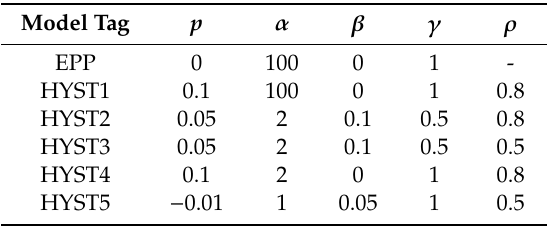
Table 2. Values of the parameters controlling the cyclic behavior of the analyzed systems (EPP: elastic-perfectly plastic model; HYST: hysteretic